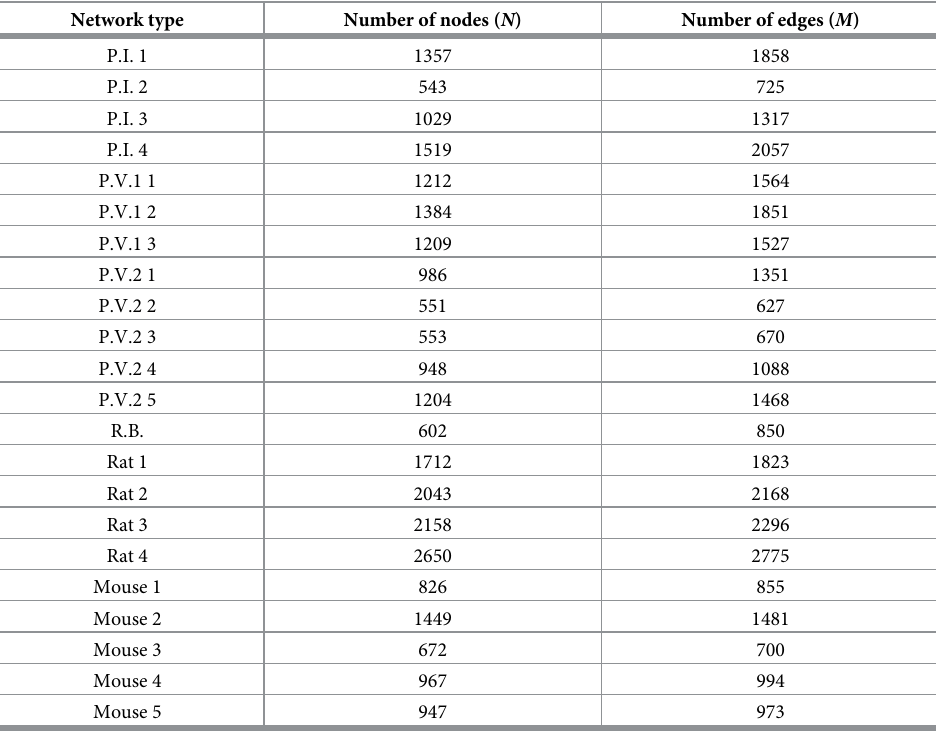
Table 1. The number of nodes and edges for all studied networks. The first grouping corresponds to the mycelial networks and the second grouping corresponds to the vasculature networks. Network type Number of nodes ( N